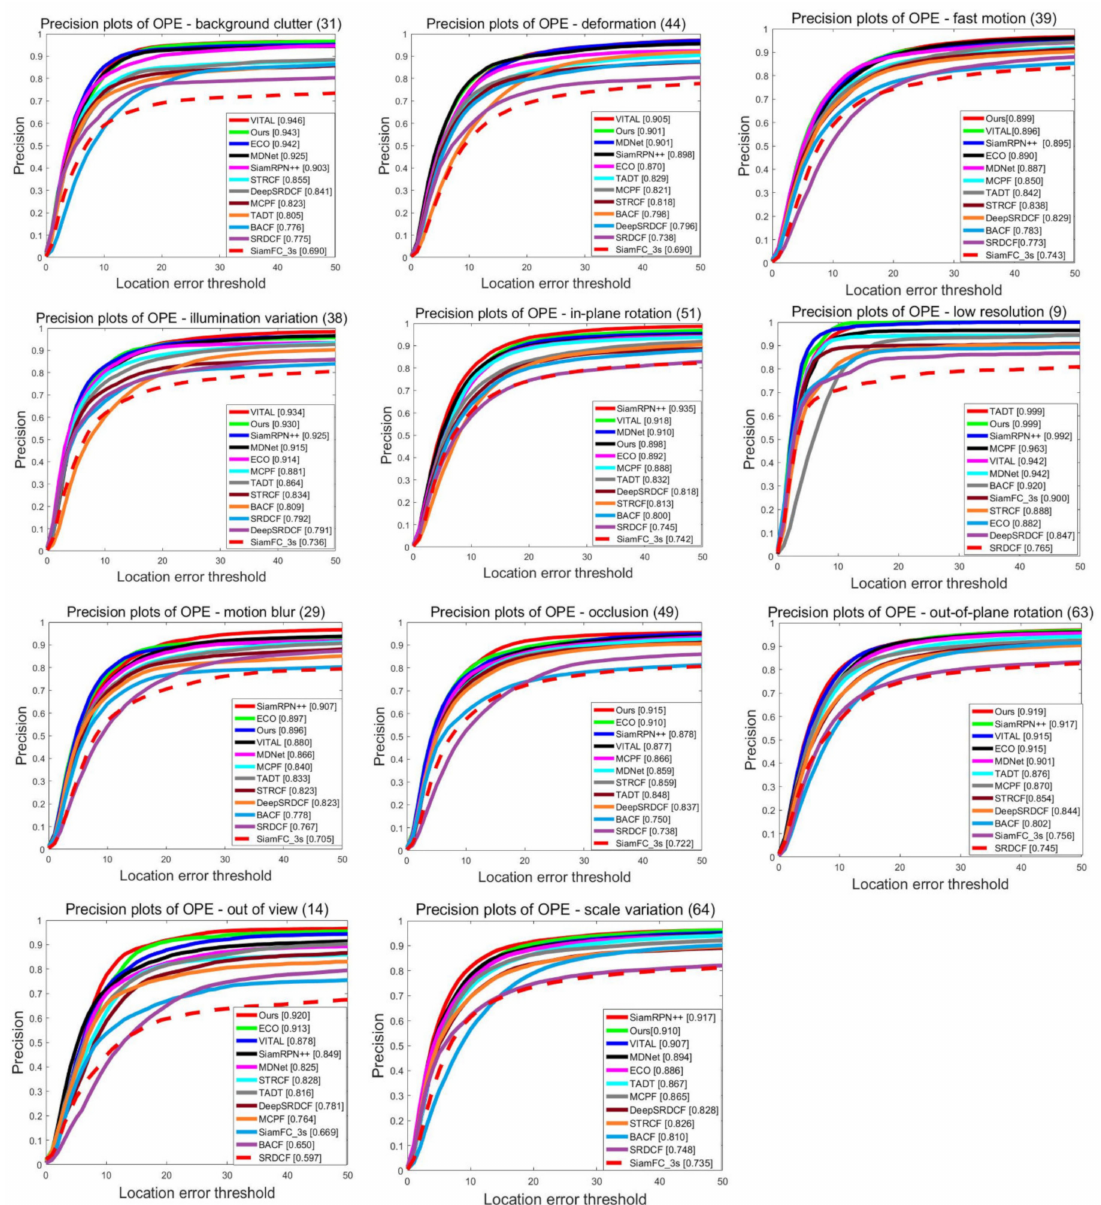
Figure 4. Precision plots of OPE on eleven video sequence attributions of OTB2015